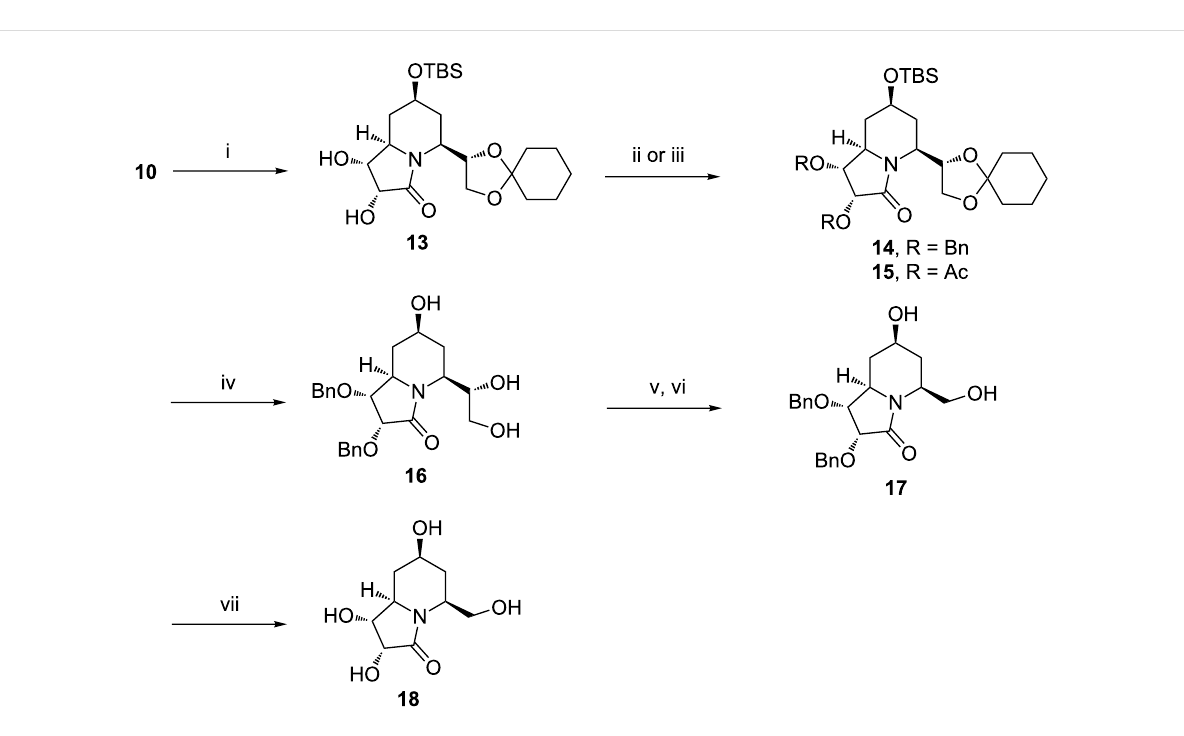
Scheme 2: Reagents and conditions: (i) OsO 4 , NMO, acetone/water, rt, 12 h, 96%. (ii) NaH, THF, BnBr, Bu 4 NI, 0 °C to rt, 6 h, 70%. (iii) Ac 2 O, pyri- dine, rt, 12 h, 80%. (iv) HCl (2 N), THF, 18 h, 89%. (v) NaIO 4 , CH 3 CN/H 2 O, 5–10 °C, 30 min, (vi) NaBH 4 , MeOH, 0°C to rt, 30 min, 92% over two steps. (vii) H 2 , Pd(OH) 2 /C, MeOH, 3 h,